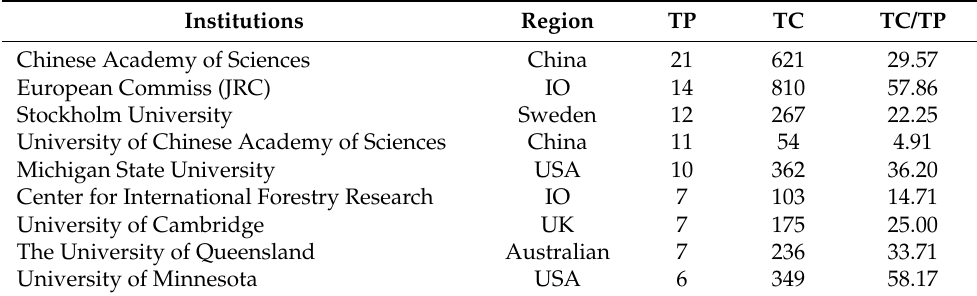
Figure 6. The cooperation network of the most productive countries. Table 3. Institutions with the highest number of publications (Top 10).